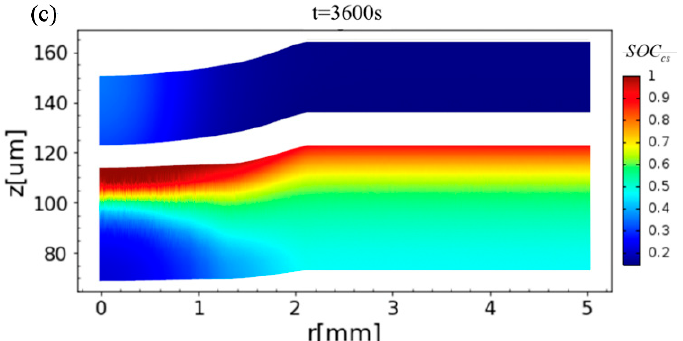
Figure 6. Distribution of the SOC cs at the positive (top) electrode and the negative (lower) electrode in the charging process when ( a ) t = 0, ( b ) t = 1800 s, and ( c ) t = 3600 s.